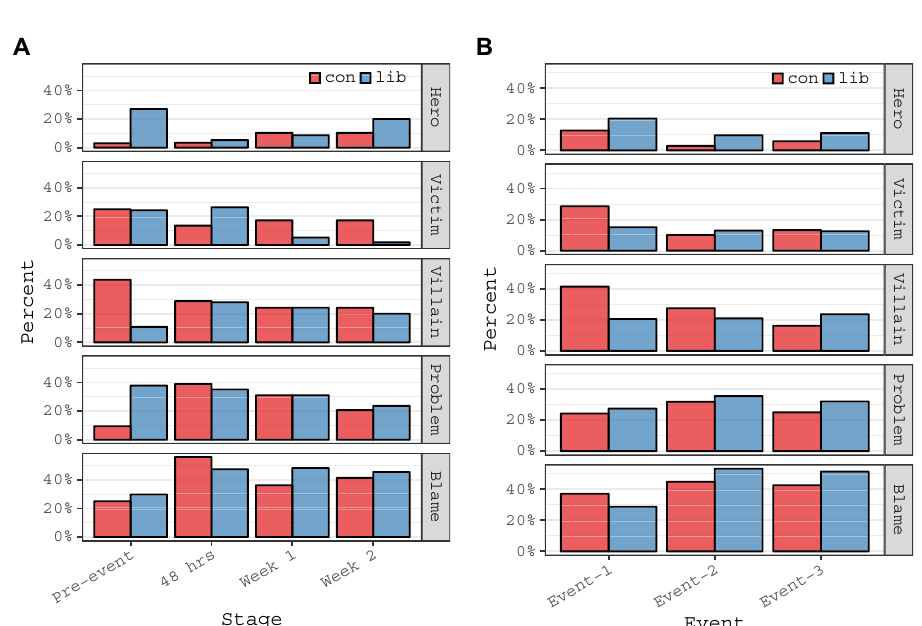
Fig. 3 The distribution of causal components across (a) different stages, and (b) events. Each bar represents the proportion of the group ’ s tweets with the corresponding category observed, at each